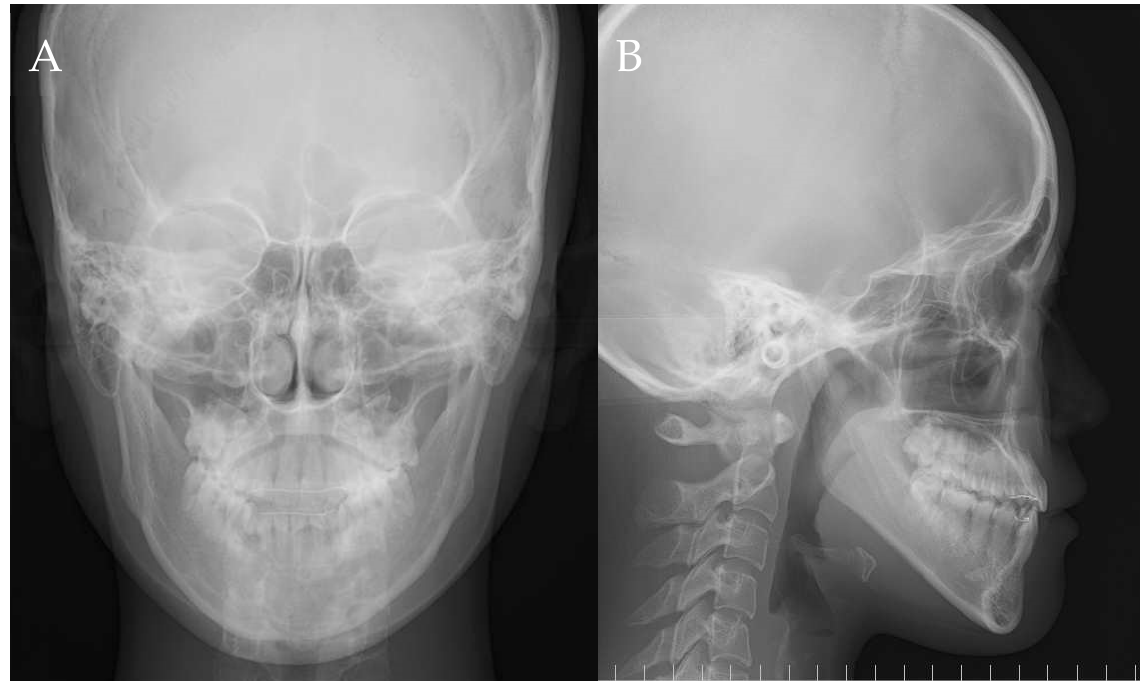
Figure 11. Post-treatment cephalometric radiograph. ( A ) Front view; ( B ) lateral view.